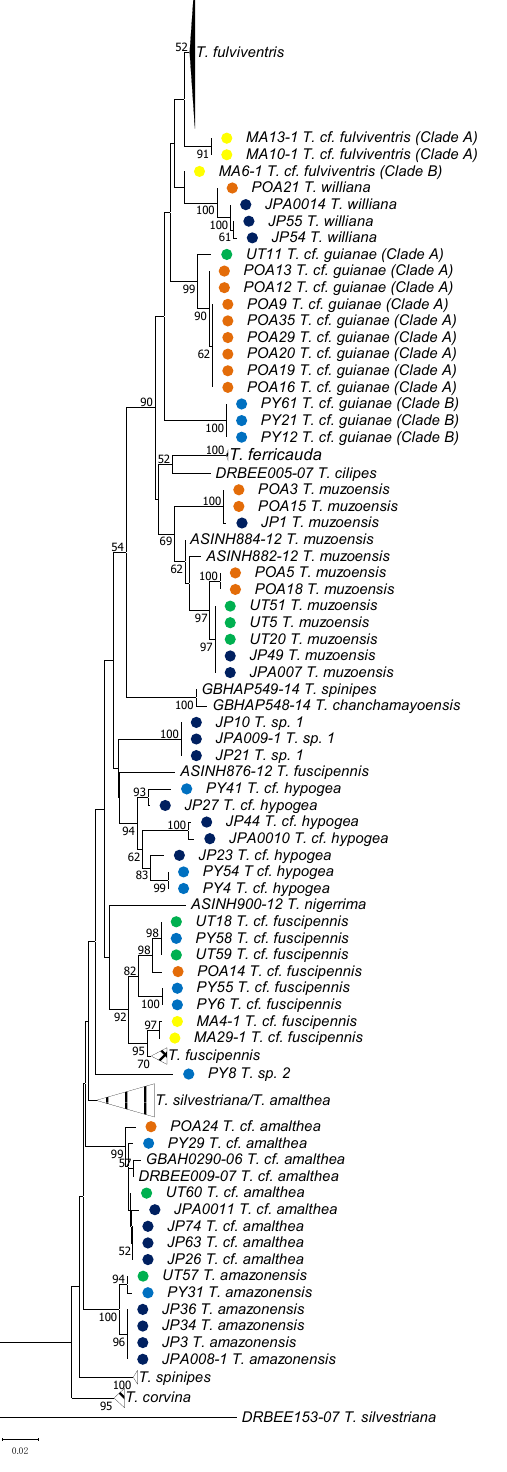
Figure 2. Neighbour-joining COI tree (K2P-corrected distances) of Trigona . Only bootstrap values > 70 are shown. Original sequence data were merged with those retrieved in BOLD. Labels of Peruvian specimens collected in this study are highlighted in different colors, according to sampling sites.